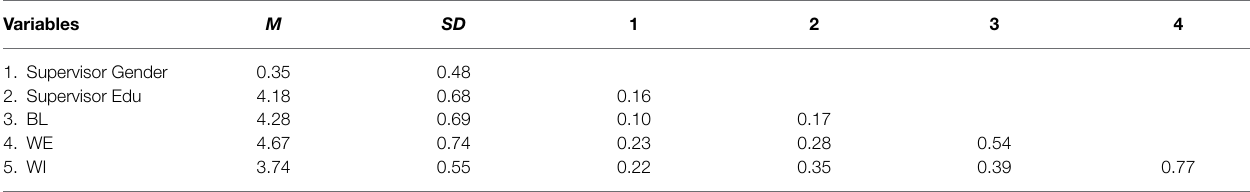
TABLE 4 | Descriptive statistics and correlations, group level. Variables